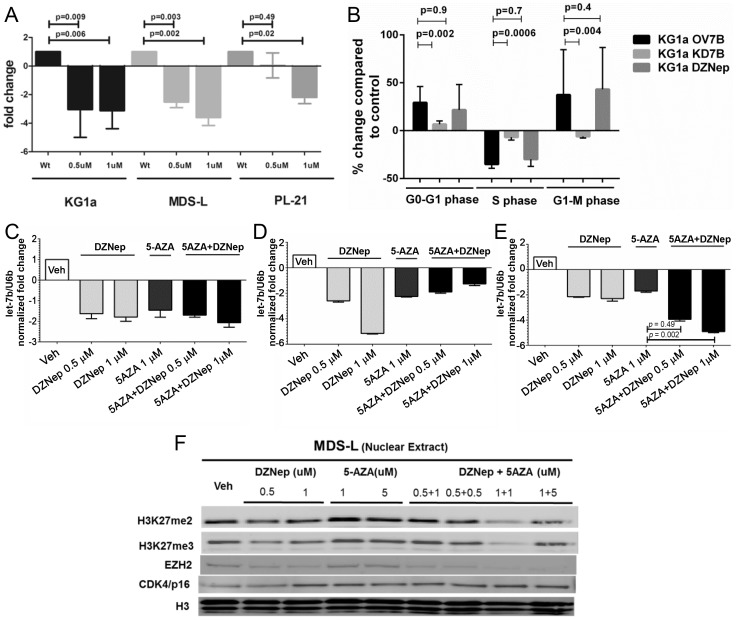
Effects of DZNep and 5AZA on let-7b and EZH2 levels.
A) DZNep exposure at different concentrations (0.5 µM and 1 µM) significantly reduced let-7b expression in KG1a, MDS-L and P-L21 cells (p = 0.005 and p = 0.002, respectively). The results are displayed as mean ±SEM of 3 similar experiments (Student t-test). B) KG1a cells treated with DZNep showed decreased cells in S phase. C) Treatment of KG1a cells, D) healthy donor cells, and E) cells from MDS marrow, with DZNep, 5AZA or a combination of both, decreased let-7b expression, more so with the combination than with 5AZA alone (p = 0.049 and p = 0.002, respectively, results show the mean±SEM of 3 experiments; Student's t-test, U6B served as loading control)); F) MDS-L cells showed decreased H3K27m2 and H3K27m3, and decreased EZH2 protein expression.; Histone H3 served as nuclear loading control. The blots show one of 3 similar experiments.